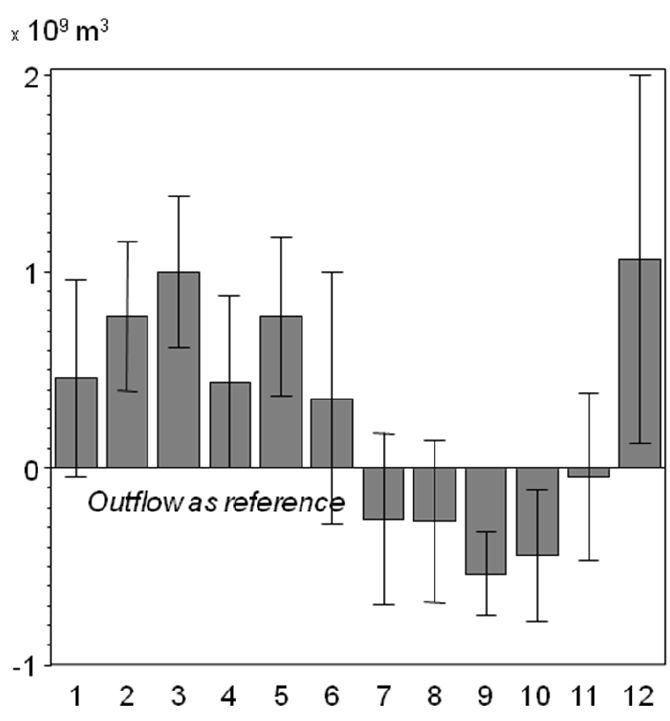
Figure 3. Monthly river inflow—outflow balance with an error confidence limit, p =